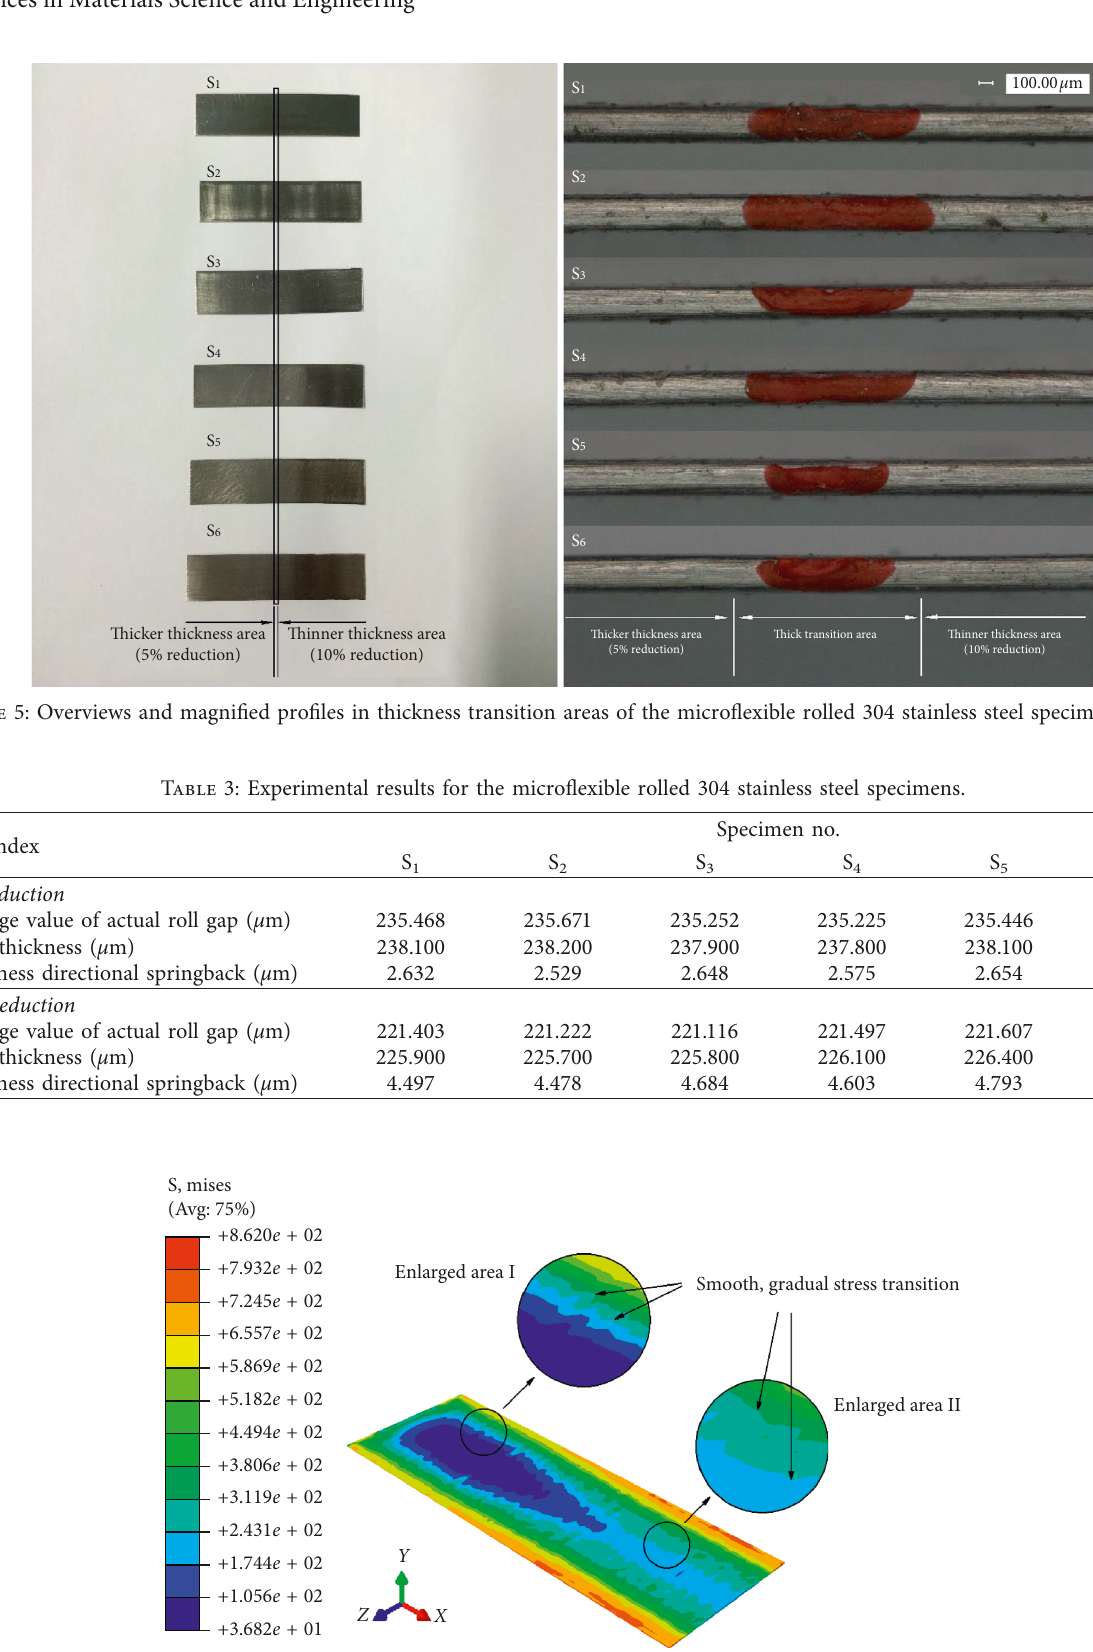
Figure 6: Distribution of effective stress in the microflexible rolled 304 stainless steel specimen S thicker thickness area with 5% reduction; enlarged area II: thinner thickness area with 10%